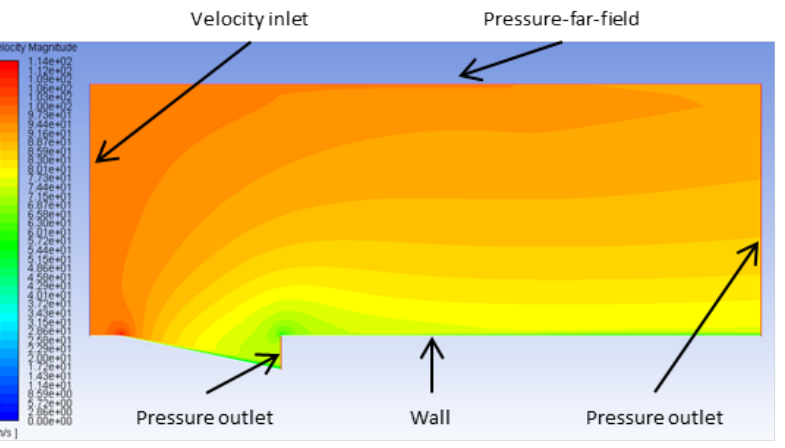
Figure 8. Example of results for flow velocity for a flush inlet using ANSYS Fluent.